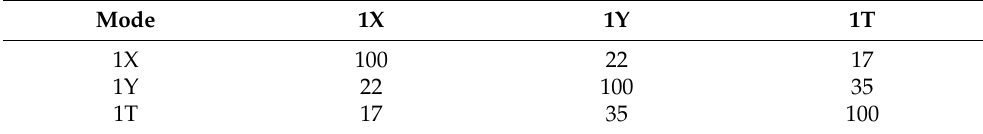
Table 4. Orthonormality checks on the first three experimental vibration modes. Percentage values.